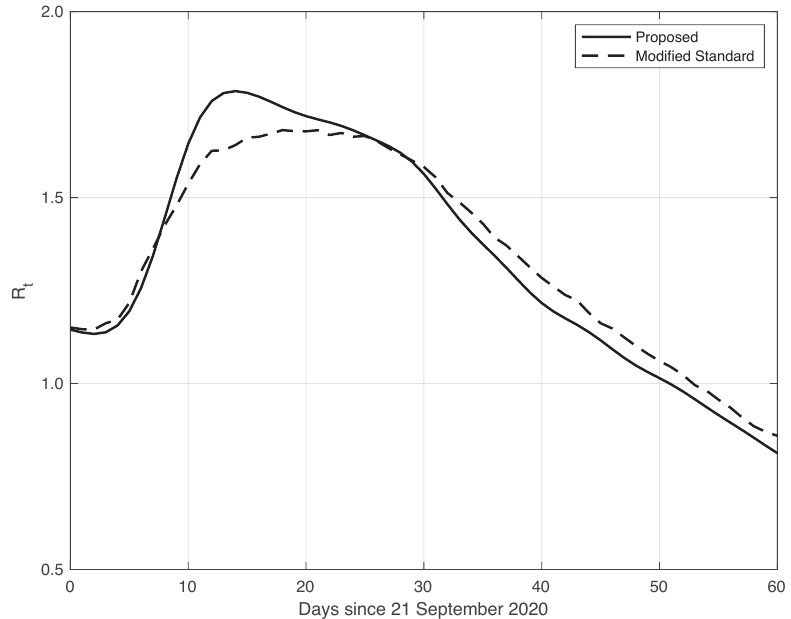
Figure 9. The same as in Figure 8, but the modified standard R t curve is now obtained by first applying estimator (6) to the data reduced by the systematic error, and then performing arithmetic averaging in time intervals I t